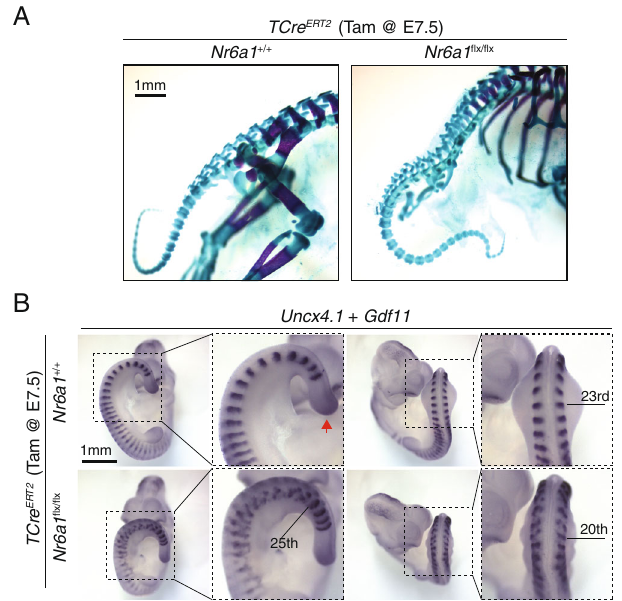
Fig. 3 | Nr6a1 function within somitic tissue is restricted to the trunk region. A Analysis of caudal elements in wildtype and TCre ER T2 ; Nr6a1 fl x/ fl x and Nr6a1 fl x/ fl x embryos ( n =13and n =8 biologicallyindependent samples, respectively) revealed no difference in vertebrae morphology or number. B Whole mount in situ hybri- disation for the somite marker Uncx4.1 revealed a rostral shift in hindlimb posi- tioning in TCre ER T2 ; Nr6a1 fl x/ fl x embryos compared to control, somite number is marked in the right panel. Additionally, somite morphology was speci fi cally dis- ruptedinthefuturethoraco-lumbarregionof TCre ER T2 ; Nr6a1 fl x/ fl x embryos,returning tonormalimmediatelyafterthehindlimbbud.Co-expressionanalysisof Gdf11 (red arrows) revealed no change in expression in the tailbud between genotypes. Con- sistent expression patterns were observed in 2 biologically independent samples/